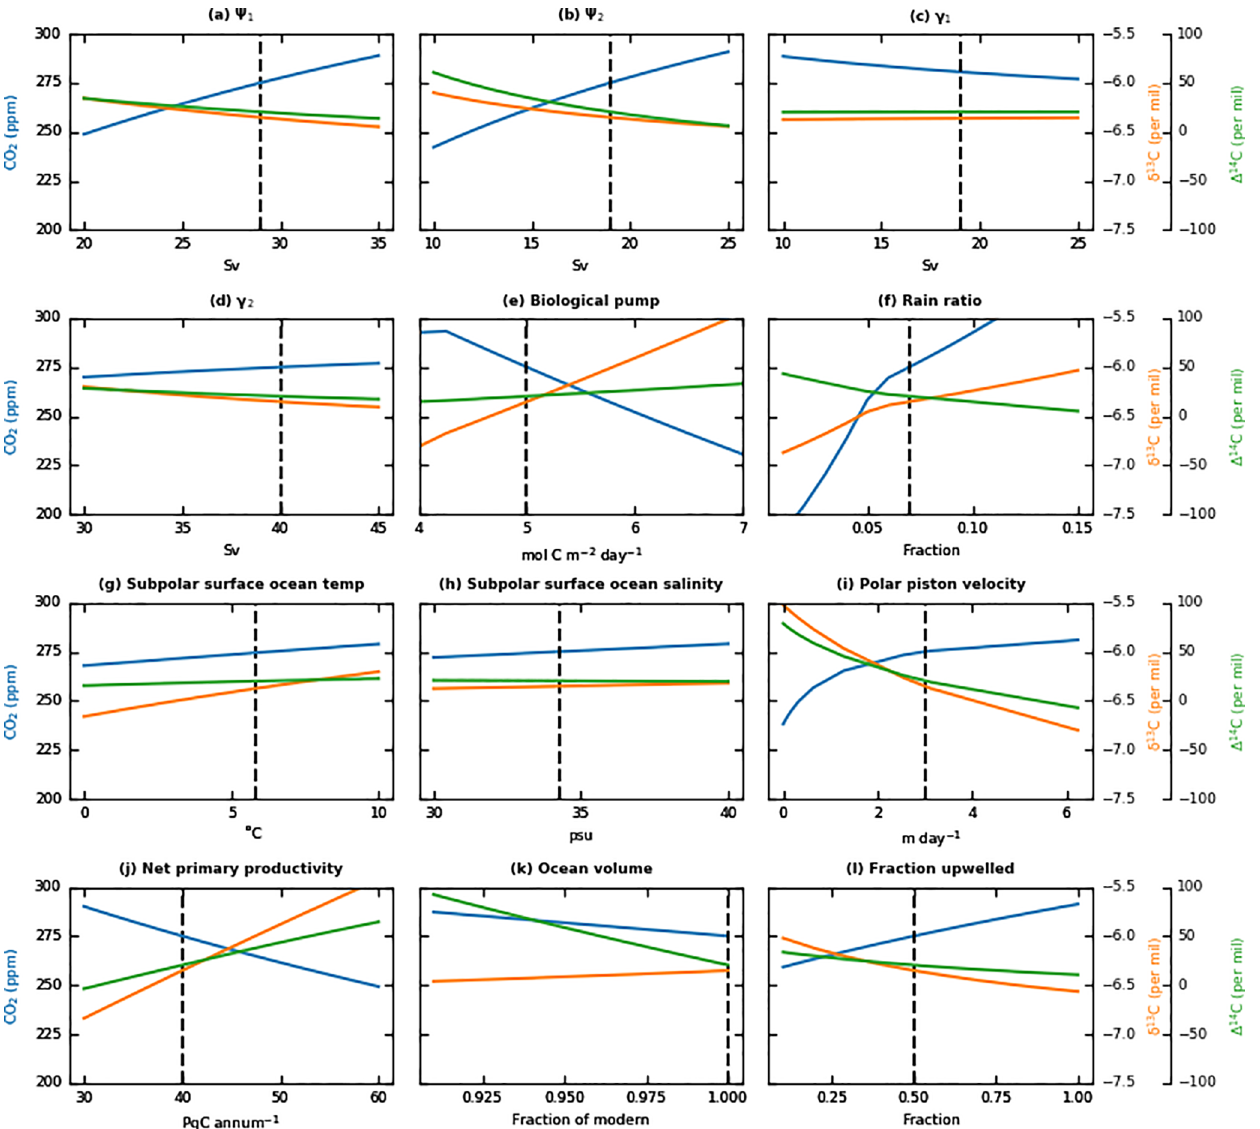
Figure 4. Univariate parameter sensitivity tests around modern-day estimated values plotted for atmospheric CO 2 , (cid:49) 14 C and δ 13 C ver- sus (a) (cid:57) 1 , (b) (cid:57) 2 , (c) γ 1 , (d) γ 2 , (e) biological pump, (f) rain ratio, (g) subpolar surface box temperature, (h) subpolar surface box salinity, (i) polar box piston velocity, (j) net primary productivity, (k) ocean volume and (l) fraction of deep water upwelled into the subpolar surface box. We varied parameter input values as plotted on the x axes and show model output for atmospheric CO 2 , (cid:49) 14 C and δ 13 C. Atmospheric CO 2 shows the greatest sensitivity to parameters associated with ocean circulation, biology and the terrestrial biosphere. Other parameters exert less influence on atmospheric CO 2 but are important for atmospheric carbon isotope values. Modern-day estimates used in SCP-M are shown with vertical black dotted lines in each subplot (sources in the text and Appendix Table